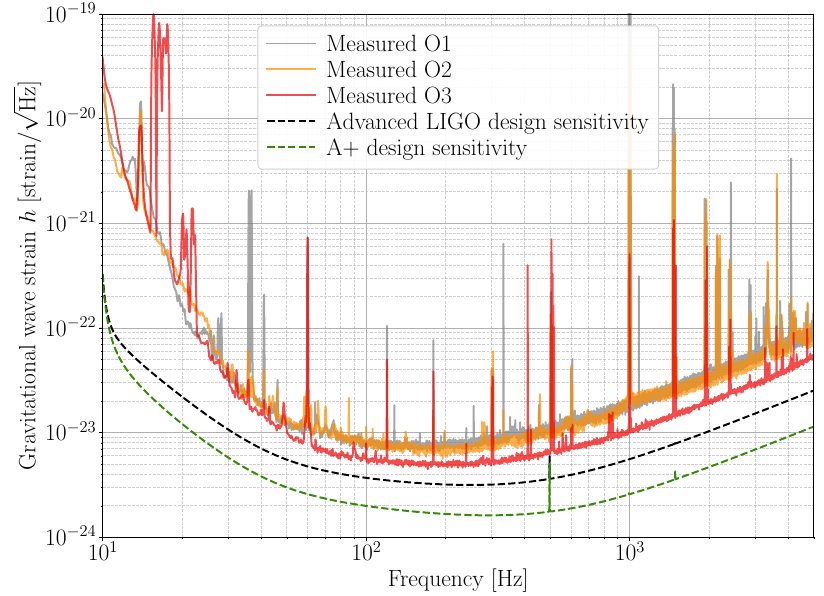
Figure 5. Comparison of LIGO Hanford gravitational wave noise spectra from O1 [4], O2 [126], and O3 [8]. Only the measured O3 spectrum includes squeezed light injection. The Advanced LIGO design sensitivity assumes no squeezing, with 125 W input laser power input yielding 750 kW circulating arm power [2,105]. The A + design sensitivity includes 12 dB squeezing and a factor of two lower coatings thermal noise